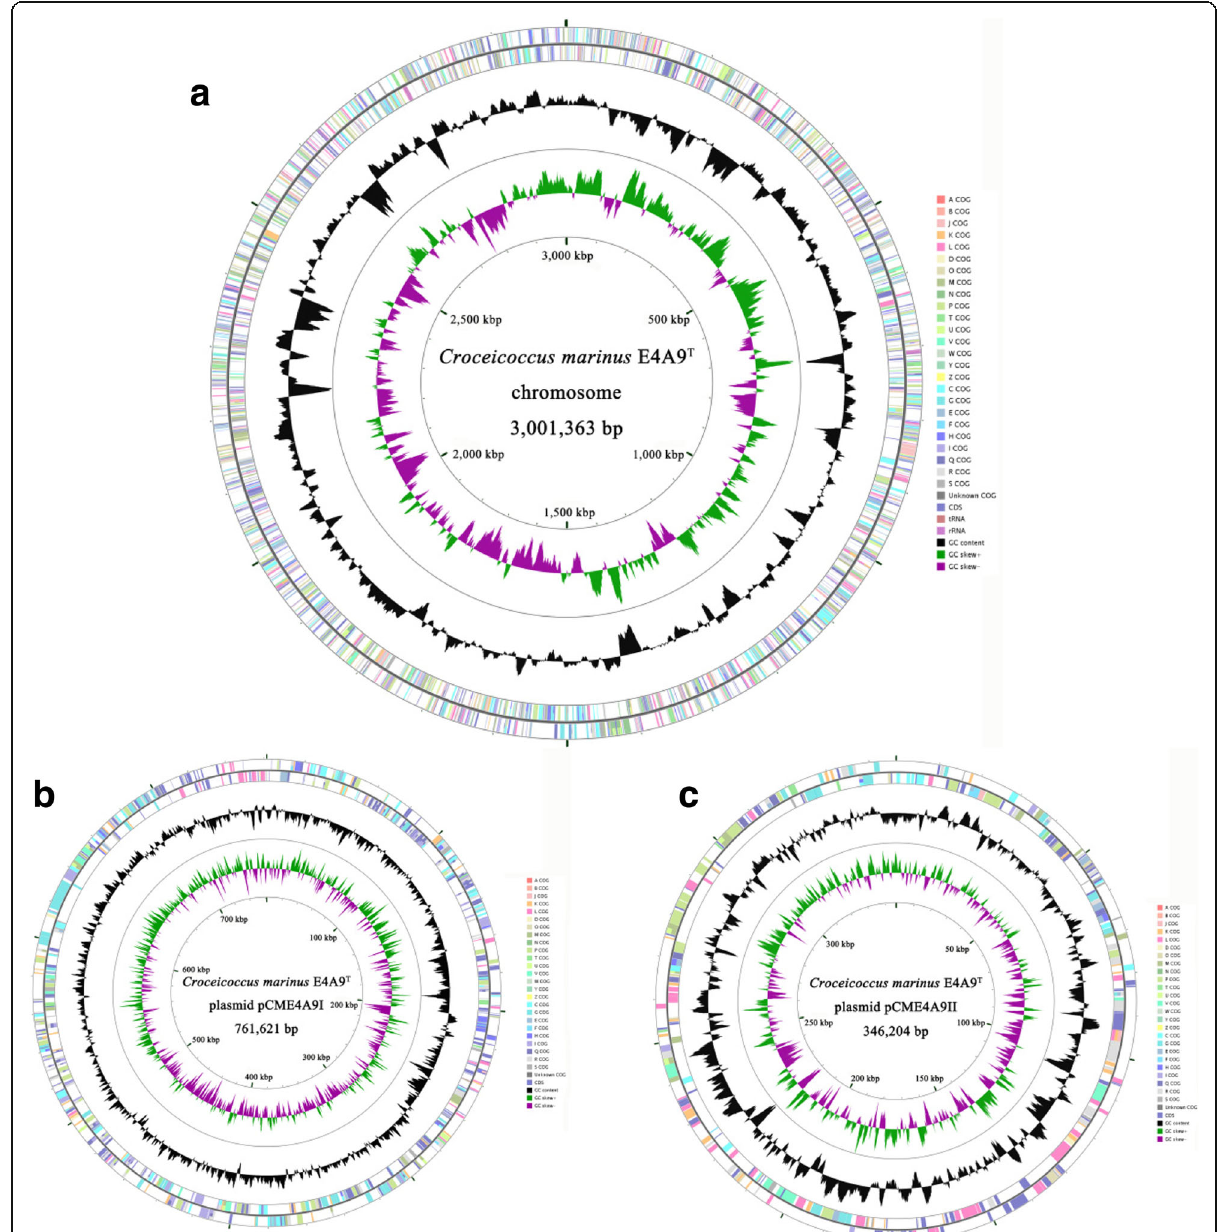
Fig. 3 Circular map of the chromosome ( a ), plasmid pCME4A9I ( b ) and plasmid pCME4A9II ( c ). From outside to the center: CDSs and RNA genes on the forward strand (colored by COG categories), CDSs and RNA genes on the reverse strand (colored by COG categories), G + C content (peaks out/inside the circle indicate values higher or lower than the average G + C content, respectively), GC skew (calculated as (G-C)/(G + C), green/purple peaks out/inside the circle indicate values higher or lower than 1, respectively), genome